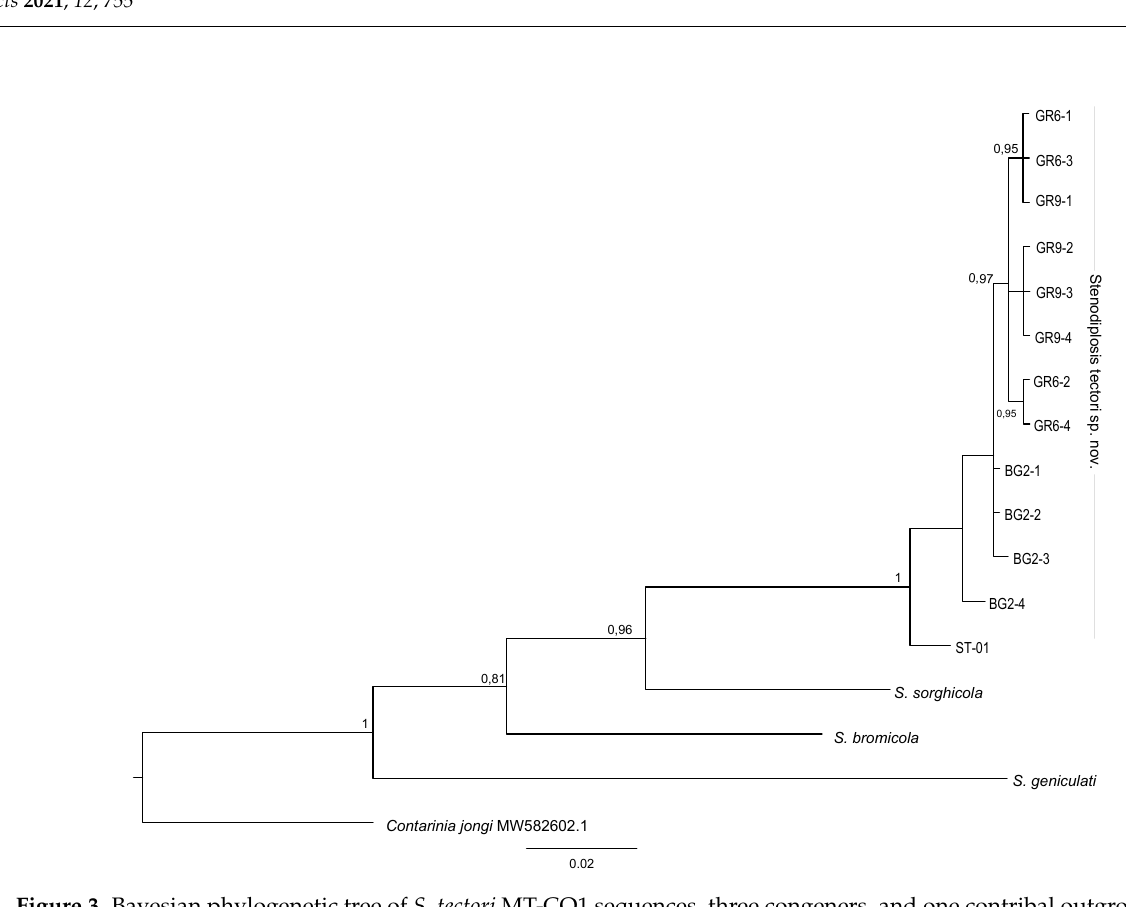
Figure 3. Bayesian phylogenetic tree of S. tectori MT-CO1 sequences, three congeners, and one contribal outgroup. Only significant posterior probabilities (>0.8) obtained from the Bayesian analysis are shown at the nodes. The scale bar indicates the expected number of substitutions per site. Tips labels refer to specimen IDs listed in Table 1.